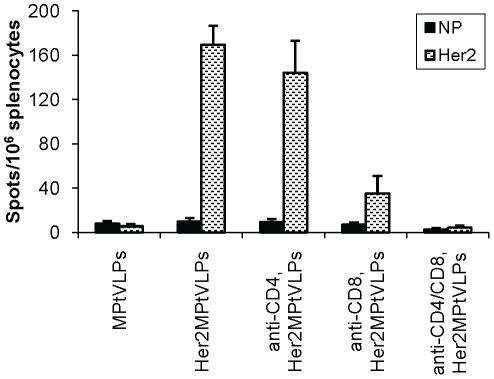
IFNγ responses following depletion of immune cells in BALB/c mice.Mice were depleted of CD4+ and/or CD8+ cells 5 and 2 days before immunisation with Her2MPtVLPs. The IFNγ response was measured 7 days later by stimulating splenocytes with the immunodominant CD8+ peptide Her263–71 or the control peptide NP118–126. Average values of triplicates from six animals are shown. Background values (stimulation in the absence of peptide) have been subtracted. Error bars represent S.E.